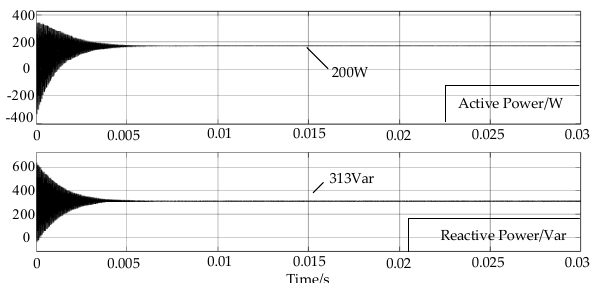
Figure 31. ϕ AD = 96.3 ◦ and ϕ AB = 192 ◦ active power and reactive power waveforms.